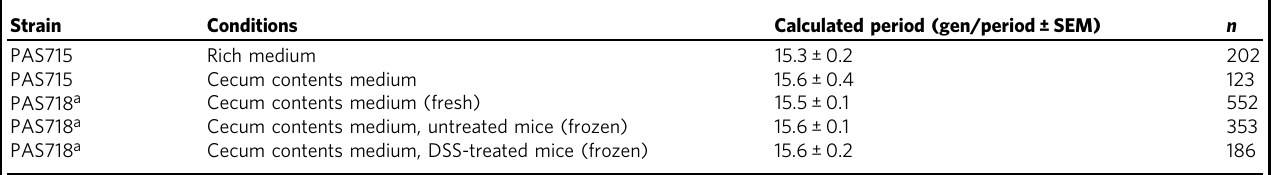
a PAS718 = PAS715 expressing a constitutive fl uorescent marker for accurate cell